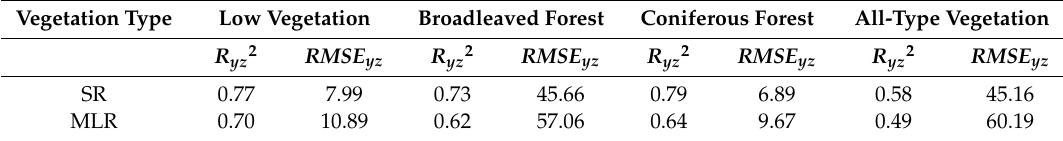
Table8. ComparingtheaccuraciesoftheSRandMLRbiomassestimationmodels(unitfor RMSE :t / hm 2 ).